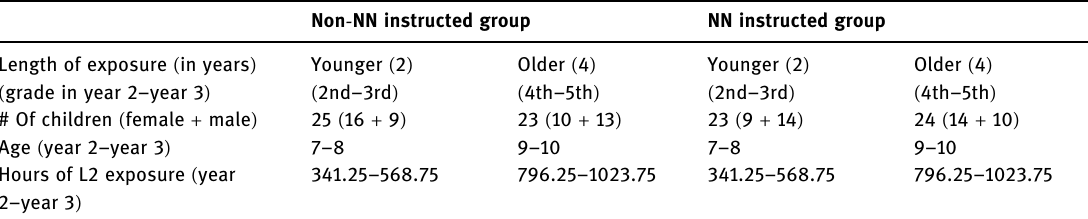
Table 1: Participant groups Non - NN instructed group NN instructed